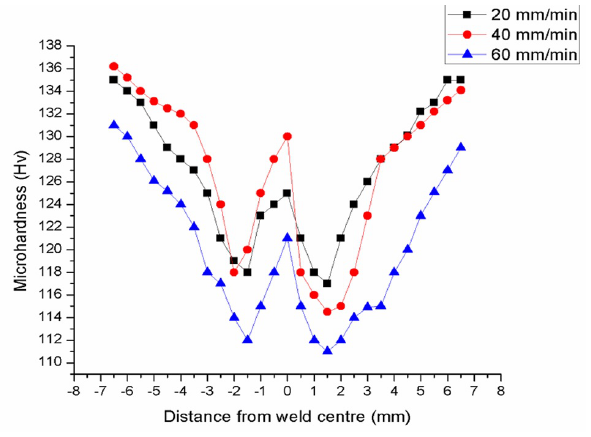
Figure 14: Effect of shoulder diameter on microhardness